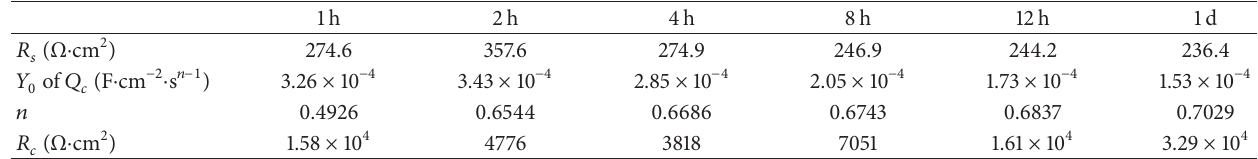
Figure 4: Impedance spectra of epoxy antirust painted samples with scratch after different immersion time in 3.5 wt% NaCl solution: (a) Nyquist plots and (b) Bode plots. Table 3: Impedance value of painted samples without scratch calculated from EIS